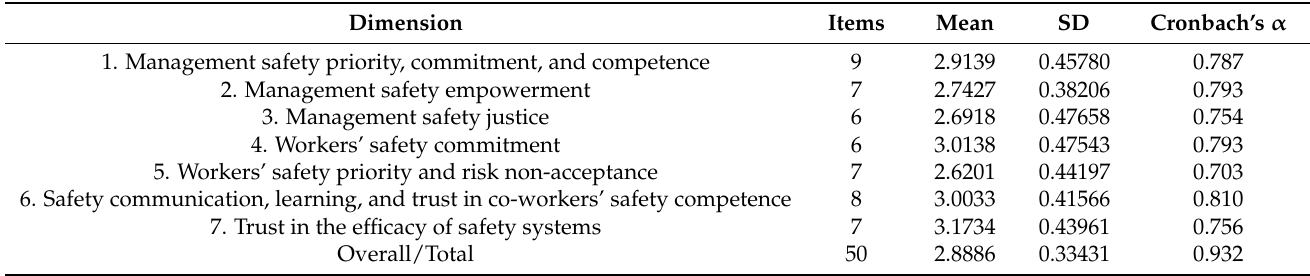
Table 1. Distribution of the mean and Cronbach’s alpha reliability test across the seven dimension using the NOSACQ-50. Dimension Items Mean SD Cronbach’s α